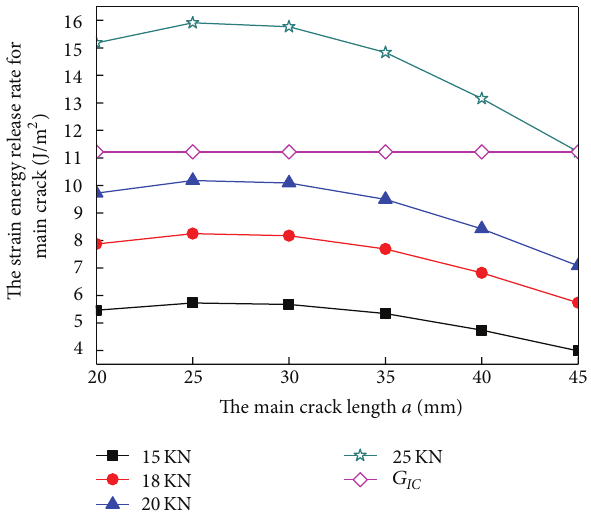
Figure 10: The plot of SERR against the main crack